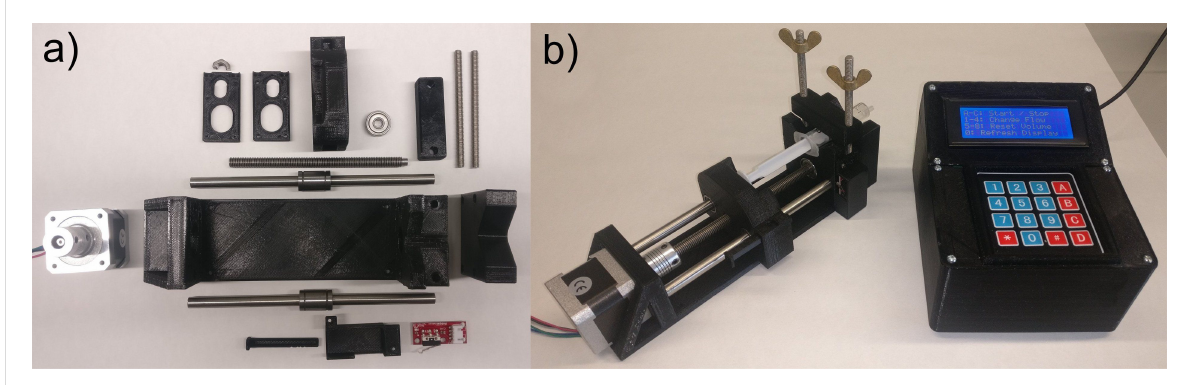
Figure 5: a) Unassembled parts used for one syringe pump. b) Assembled pump with controller.